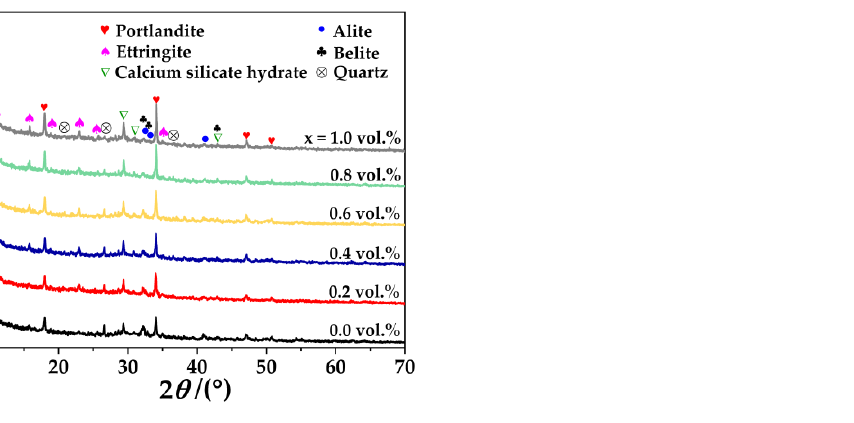
Figure 3. XRD patterns of Bi 0.5 Sb 1.5 Te 3 /CNTs cement composites with different Bi 0.5 Sb 1.5 Te 3 contents.